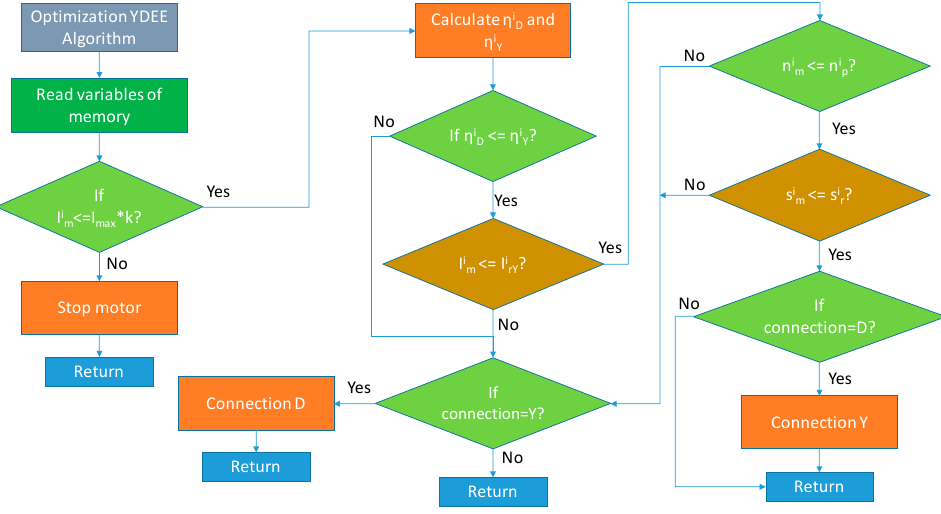
Figure 7. YDEE optimization algorithm.